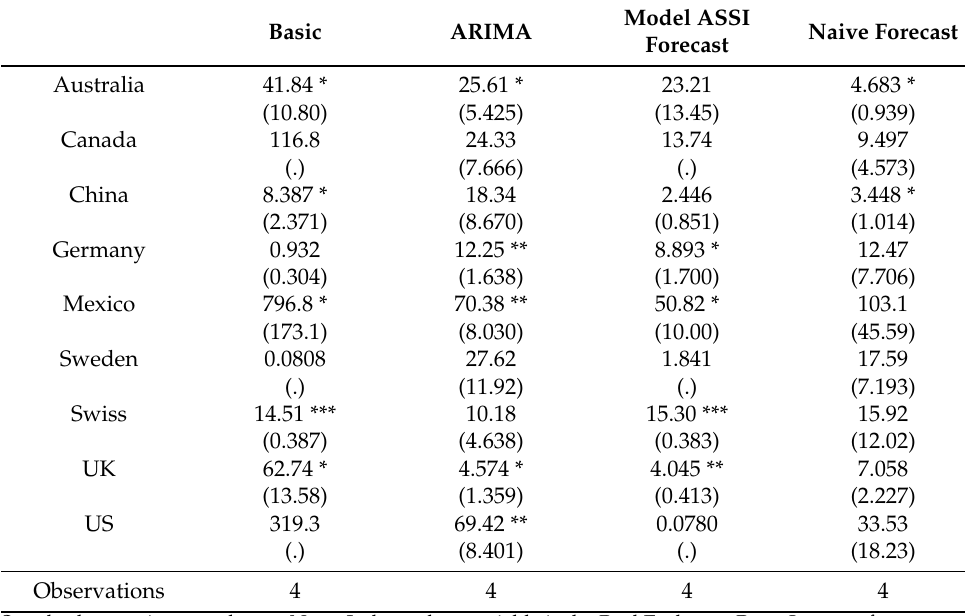
Table 8. Square-Mean Error of Forecasting after 1